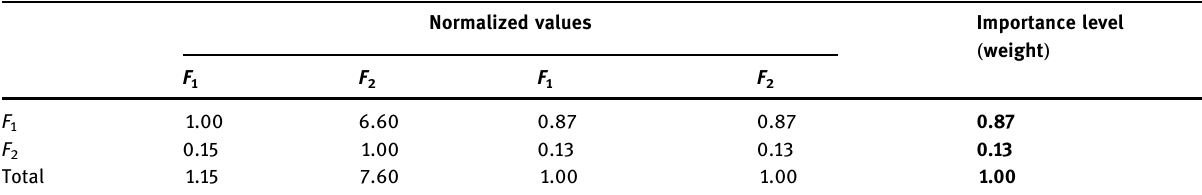
Table 6: Determining the importance level ( weight ) of external